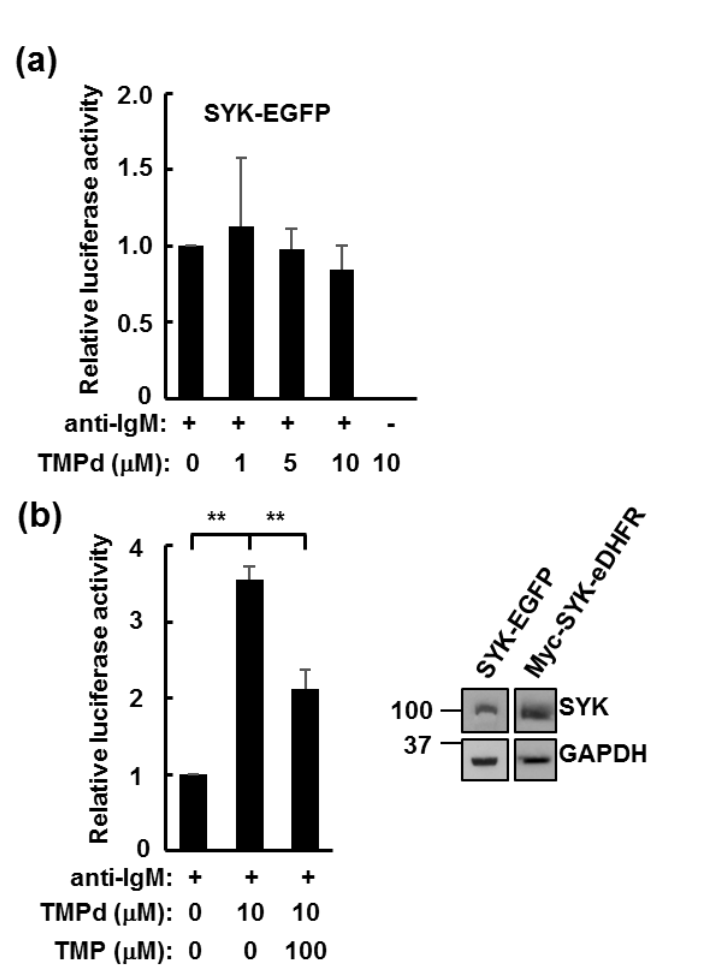
Figure 6. Enhanced Nuclear Factor of Activated T cells (NFAT) activation by the trimethoprim (TMP) dimer requires SYK dimerization. ( a ) SYK-deficient DT40 cells transiently transfected with an NFAT-driven luciferase reporter plasmid and with a plasmid for the expression of SYK-EGFP were activated by receptor crosslinking with anti-IgM where indicated in the presence of increasing concentrations of TMP dimer (TMPd). Values represent means ± standard error of the mean (SEM) of triplicate assays repeated three times; ( b ) SYK-deficient DT40 cells transiently transfected with an NFAT-driven luciferase reporter plasmid and with a plasmid for the expression of Myc-SYK-eDHFR were activated by receptor crosslinking with anti-IgM in the presence of 10 µ M TMP dimer (TMPd). Where indicated, an excess of TMP (100 µ M) was added 2 h following activation. Values represent means ± SEM of triplicate assays repeated three times. ** p < 0.01. The expression of SYK-EGFP and Myc-SYK-eDHFR were verified by Western blotting.